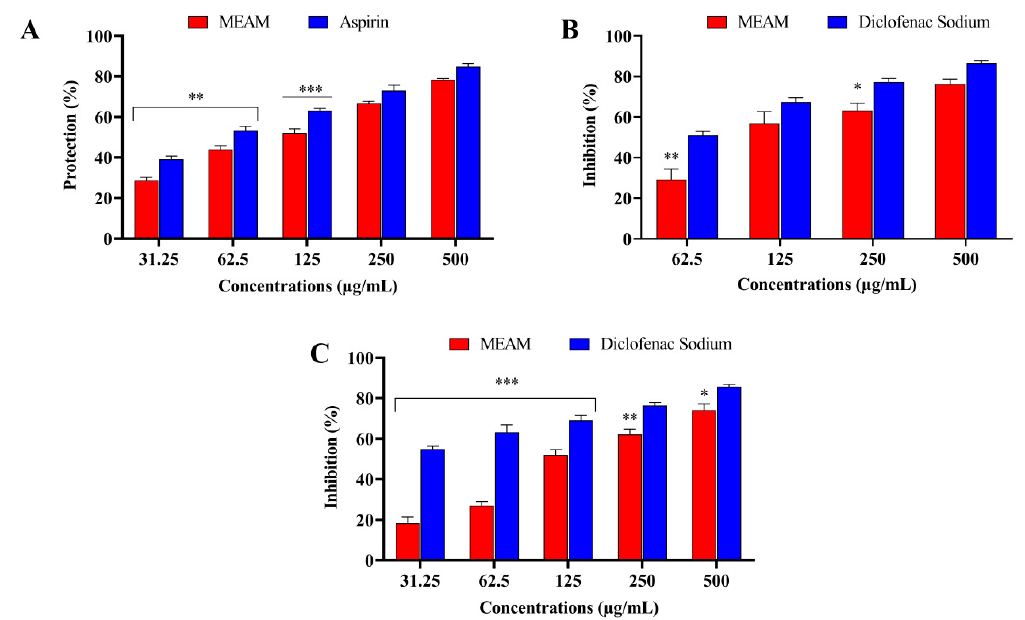
Figure 3. Anti-inflammatory activity of methanol extract of A. montanum (MEAM): ( A ) human red blood cell (HRBC) membrane stabilization; ( B ) protein denaturation by using egg albumin; and ( C ) protein denaturation by using BSA. Values are presented as mean ± S.E.M. (n = 5); * p < 0.05, ** p < 0.01, *** p < 0.001, statistically significant in comparison to control (Dunnett’s test).